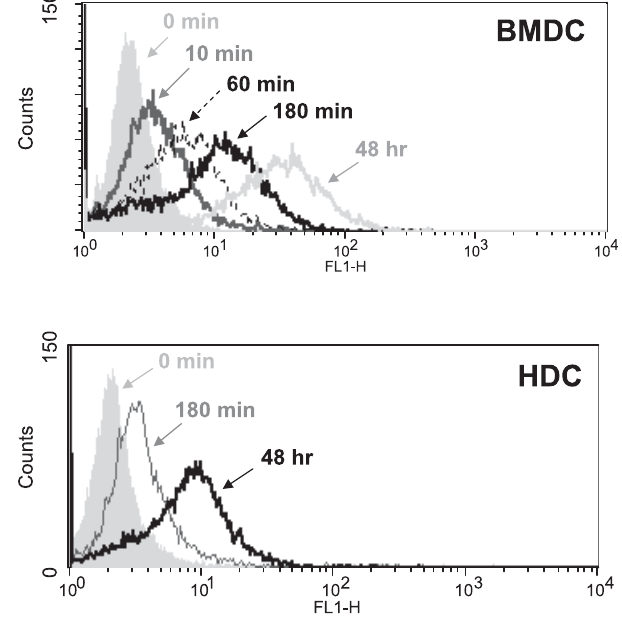
Figure 1. GXM Internalization by DCs BMDCs or HDCs were incubated with GXM for the indicated lengths of time. Cells were harvested, washed, fixed, permeabilized, stained with an anti-GXM antibody, followed by a Cy2-conjugated secondary antibody, and analyzed by flow cytometry. The experiment was done twice with similar results.